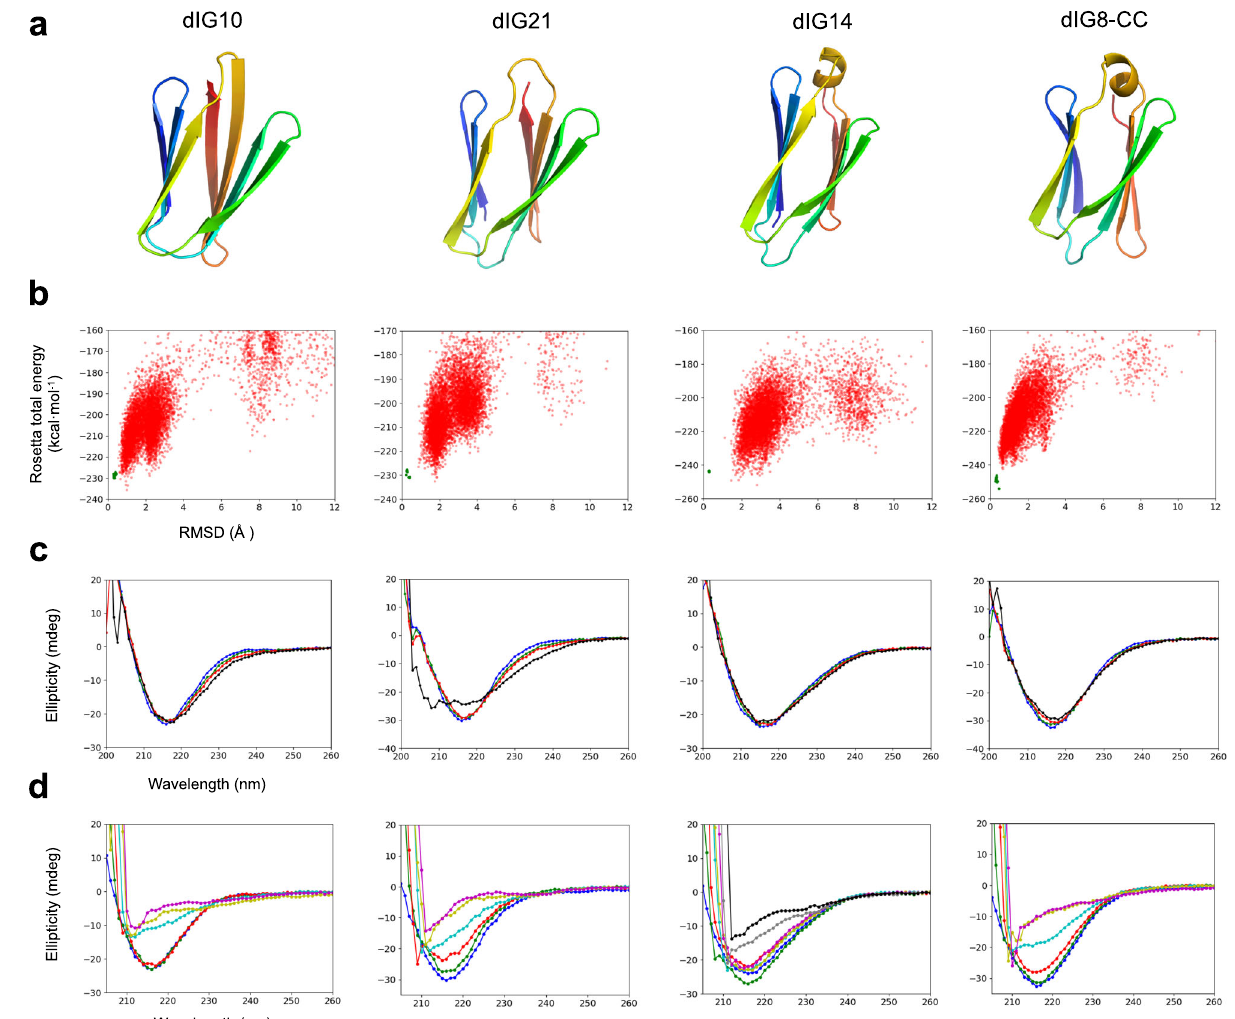
Fig. 3 | Folding and stabilityofdesignedproteins.a Examples ofdesign models. b Simulated folding energy landscapes, with each dot representing the lowest energy structure obtained from ab initio folding trajectories starting from an extendedchain(reddots)orlocalrelaxationofthedesignedstructure(greendots). The x-axis depicts the C α -RMSD from the designed model and the y-axis, the